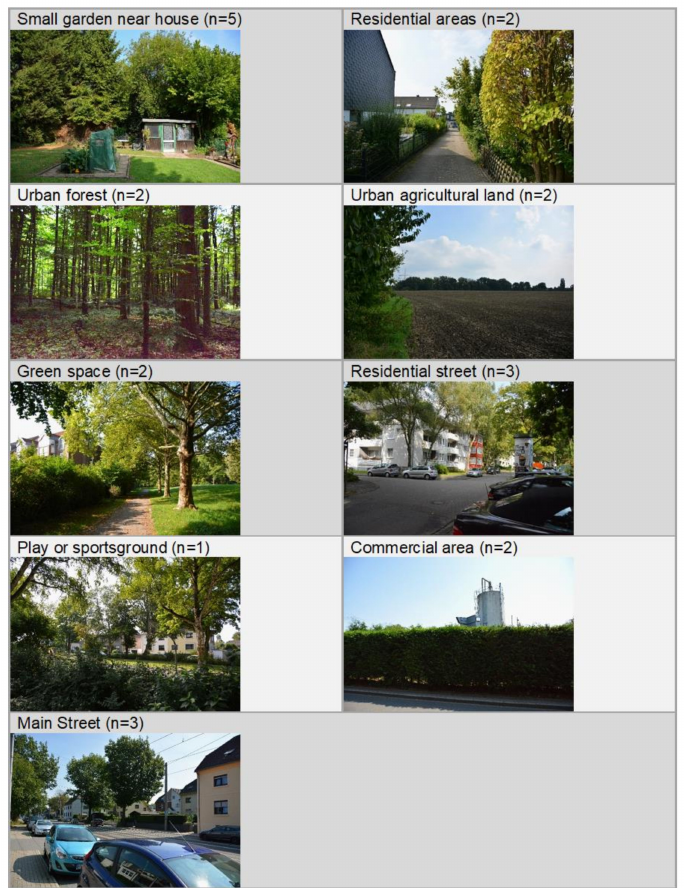
Figure 1. Land use categories and number (n) of recording locations by land use category (n = 22). Own photographs show examples of recorded locations in the respective land use